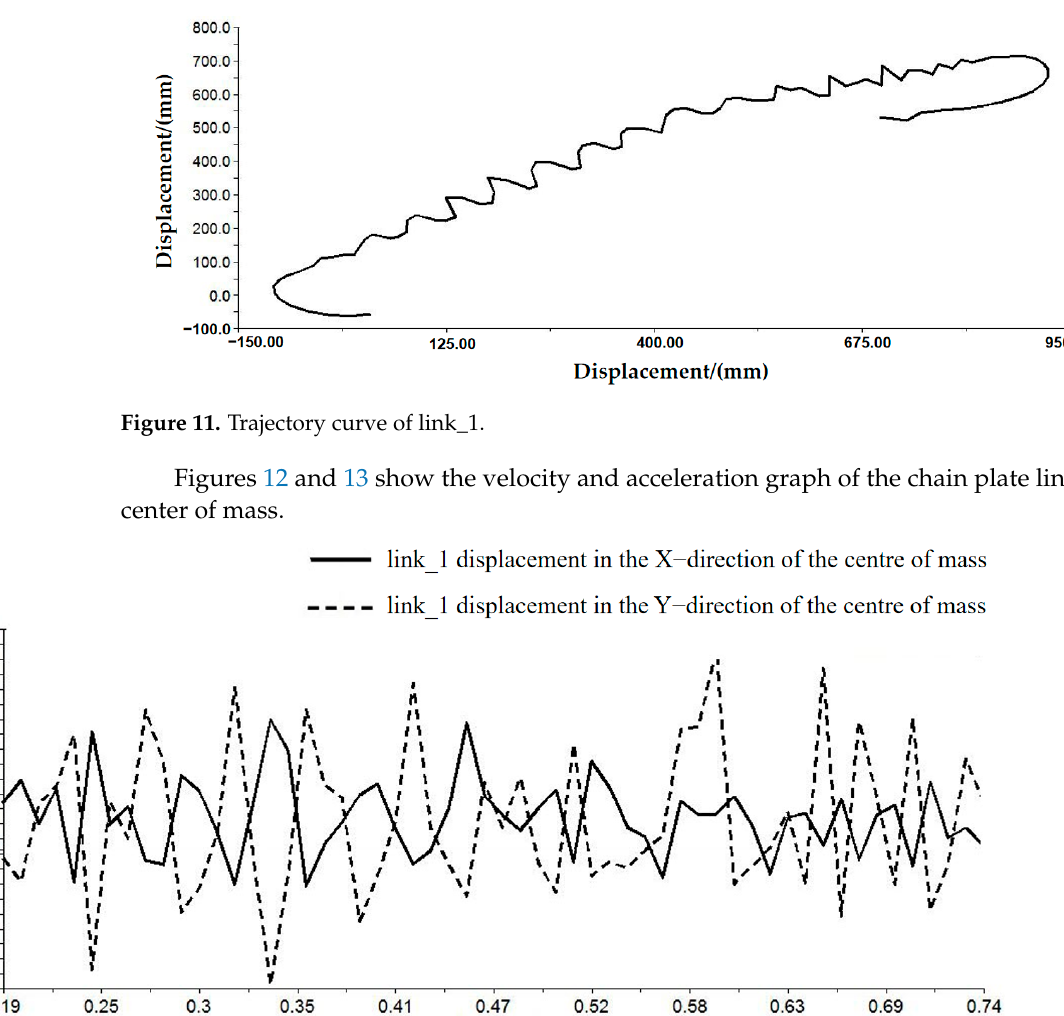
Figure 12. Velocity of link_1.